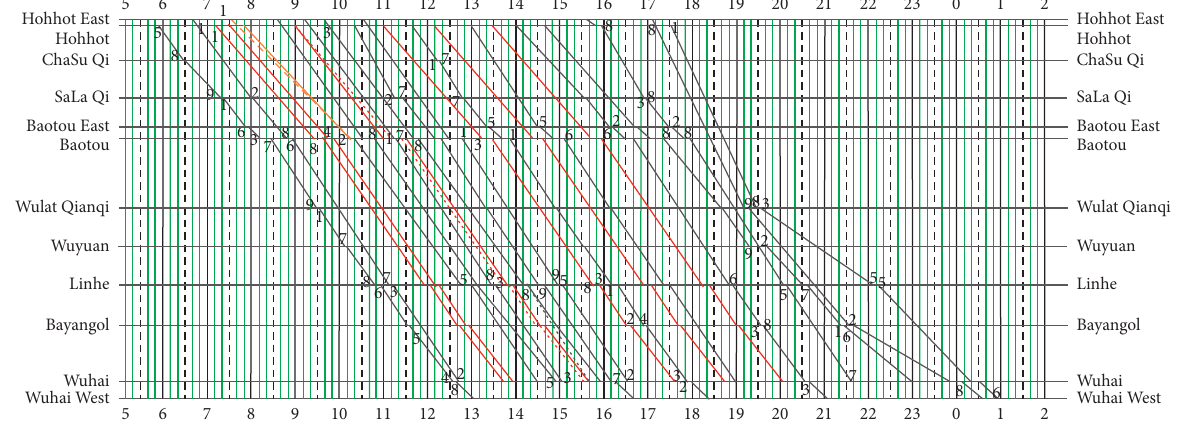
Figure 4: Timetable of Hohhot-Wuhai by increasing the CTs. Table 3: operation plans of CTs.